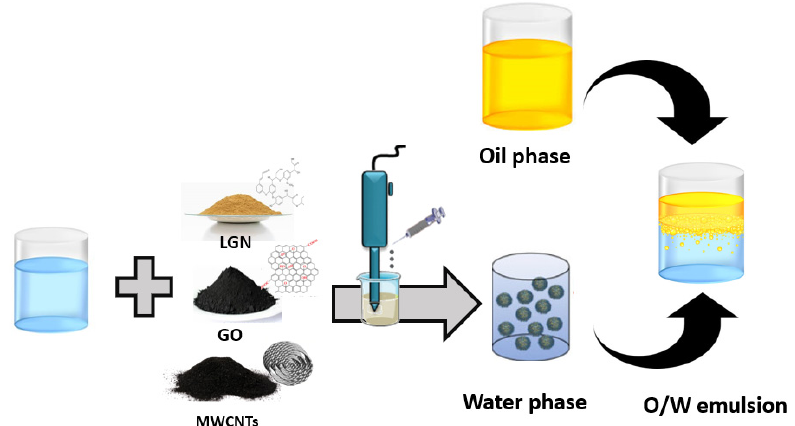
Figure 2. Experimental procedure of fabricated O/W emulsions. Table 1. Ingredients of the prepared O/W emulsions.